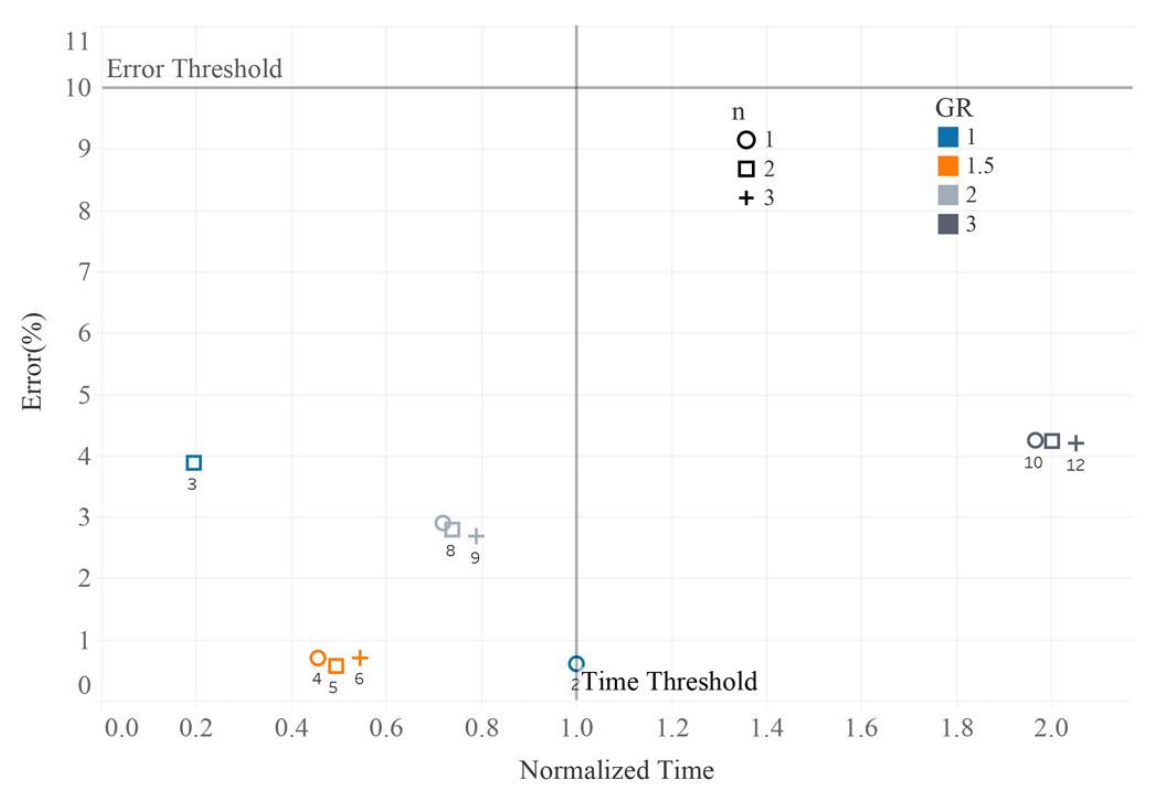
Figure 6. Effect of grid ratio (GR) and n on computational time and error for Pr = 0.01.